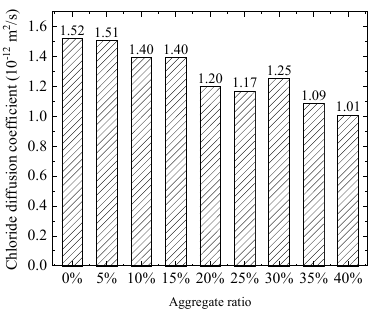
Figure 7. Equivalent chloride ion diffusion coefficient.